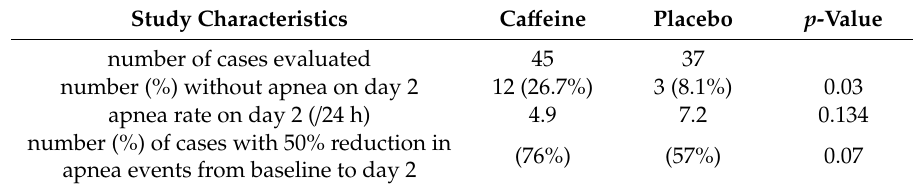
Table 3. E ffi cacy analysis in 82 / 85 preterm cases included in the ca ff eine citrate, intravenous, and enteral (CAFCIT) trial (3 cases are not included in the e ffi cacy analysis because they had < 6 apnea episodes / 24 h at baseline)